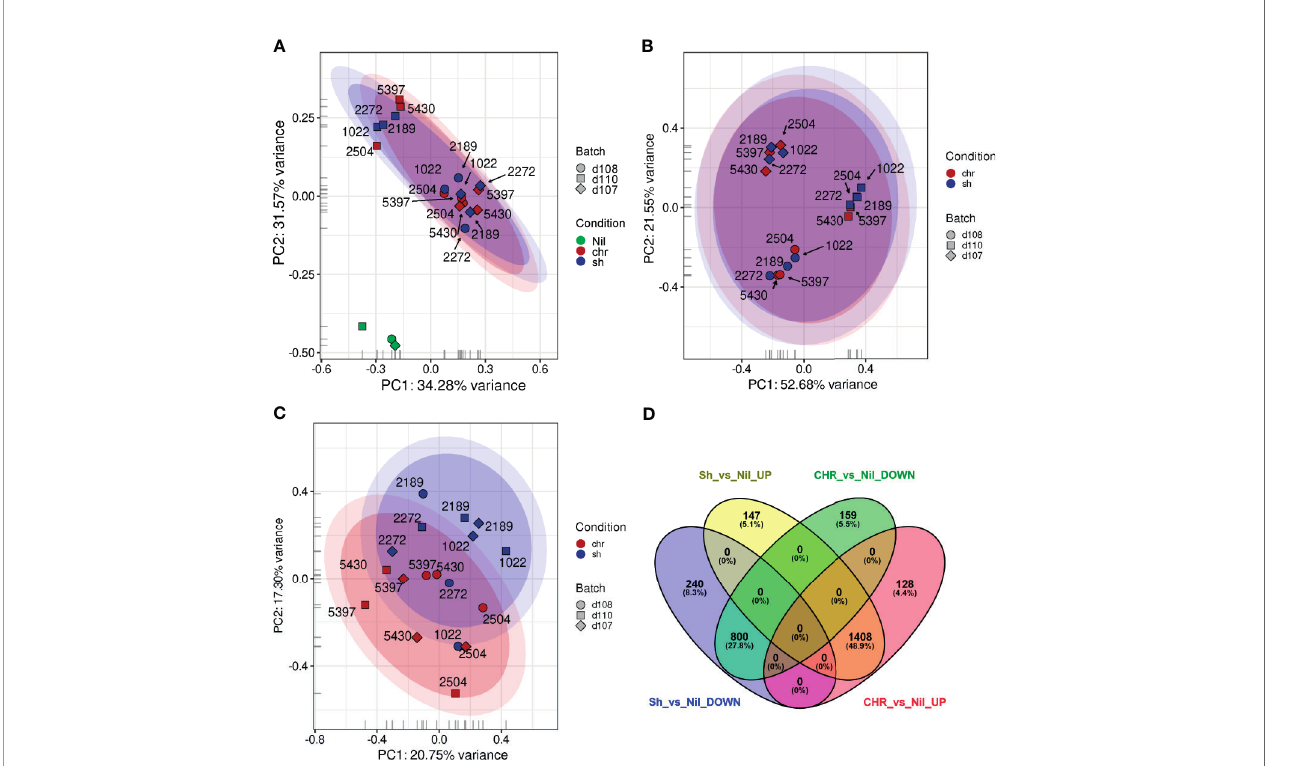
FIGURE 2 | Principal Component Analysis plots and Differential Expression analyses of PBMCs exposed to SH and CHR strains. An initial PCA was performed (A) using log 2 , quantile, count per million (cpm), low-count- fi ltered data and displayed a strong clustering with respect to the three donors (represented as the different symbol shapes). (B) This donor-speci fi c effect was made even clearer when the uninfected samples (green) were removed from the analysis. (C) When surrogate variable estimates from SVA were included, it became possible to visualize differences between the PBMCs exposed to CHR (red) and self-healing (blue) strains. (D) Venn diagrams showing the relationships between the overlaps of differentially expressed genes in SH vs. uninfected (Nil) and CHR vs. uninfected